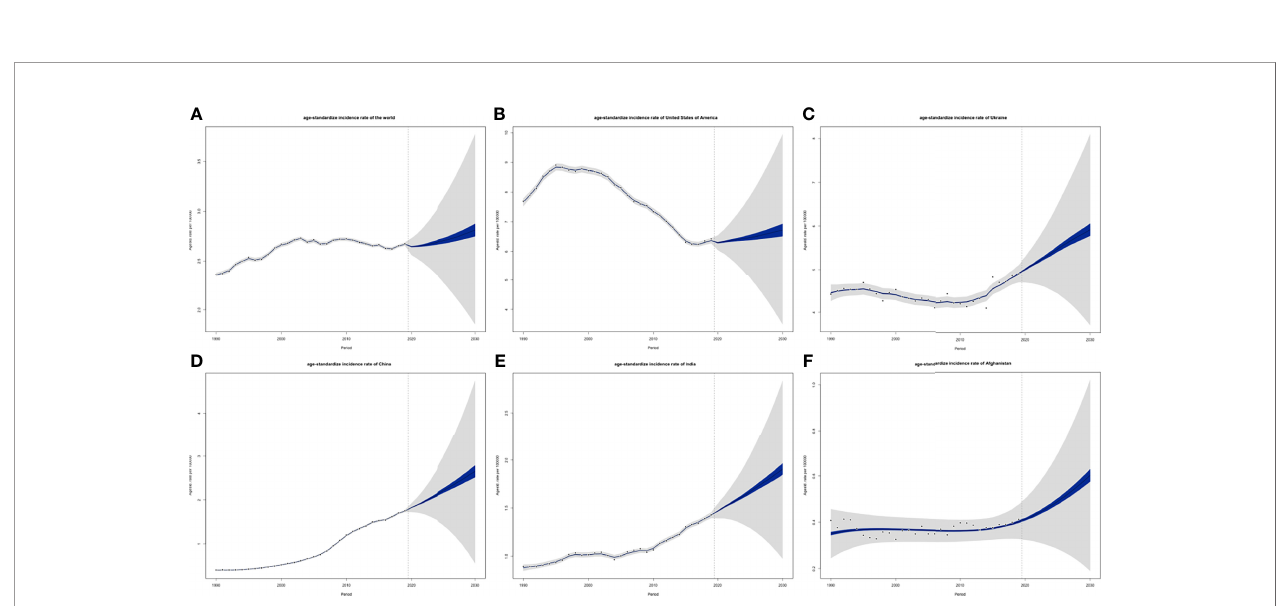
FIGURE 13 | Projections of ASIRs of (A) the world, (B) USA, (C) Ukraine, (D) China, (E) India and (F) Afghanistan from 2020 to 2030: blue areas are 5% con fi dence intervals and grey areas are 95% con fi dence intervals; black dots are observation value from 1990 to 2019 (ASIR, age-standardized incidence